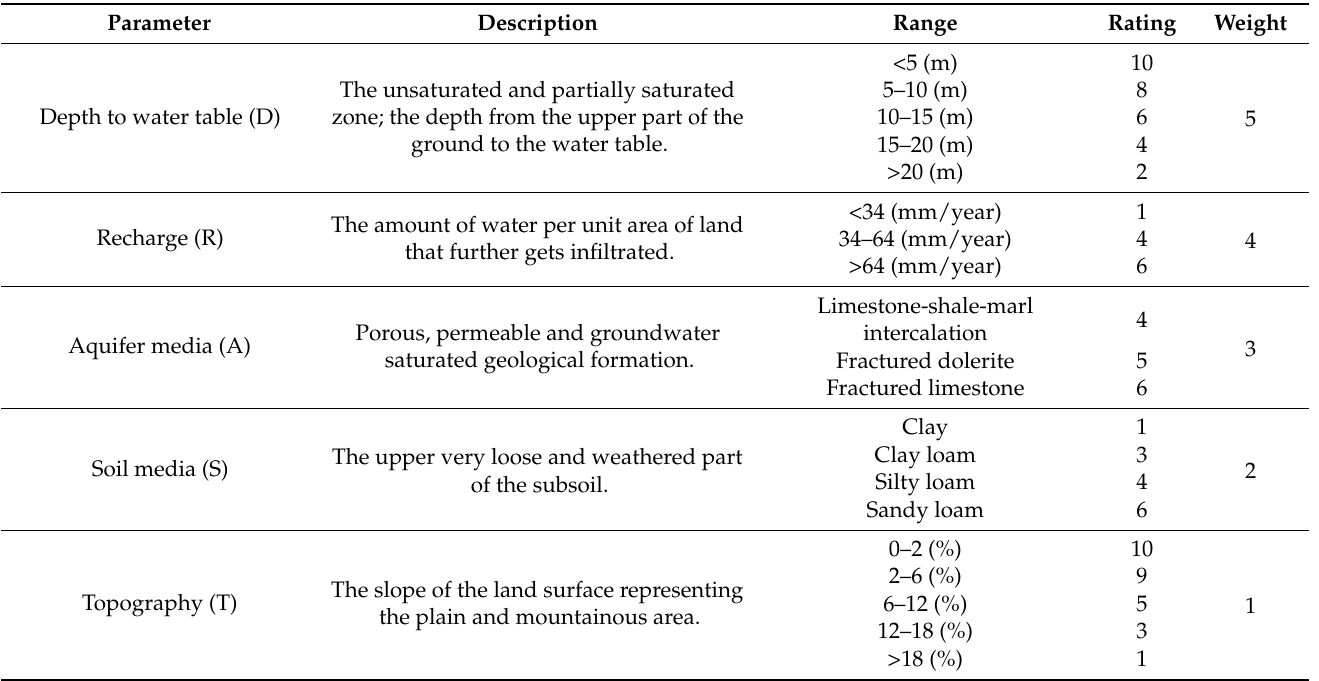
Table 1. The DRASTIC method parameters [34], together with the ratings and weights for the study area. Parameter Description